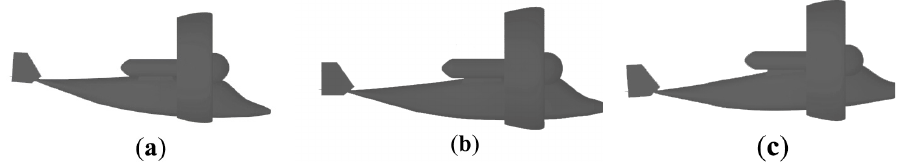
Figure 6. Schematic diagram of aircraft pitching. ( a ) Negative pitch. ( b ) Horizontal. ( c ) Positive pitch.